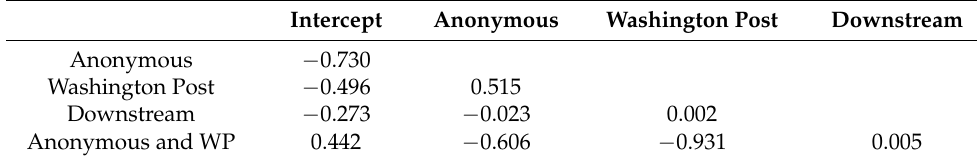
Table A4. Correlation of Fixed